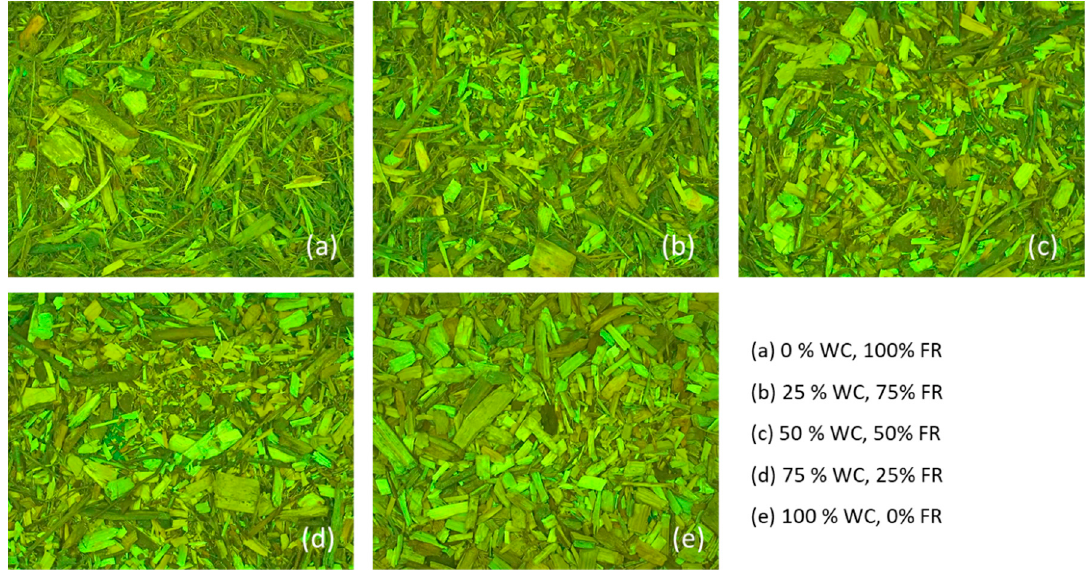
Figure 1. Exemplary photos of different fuel mixture classes (taken with green ambient lighting).